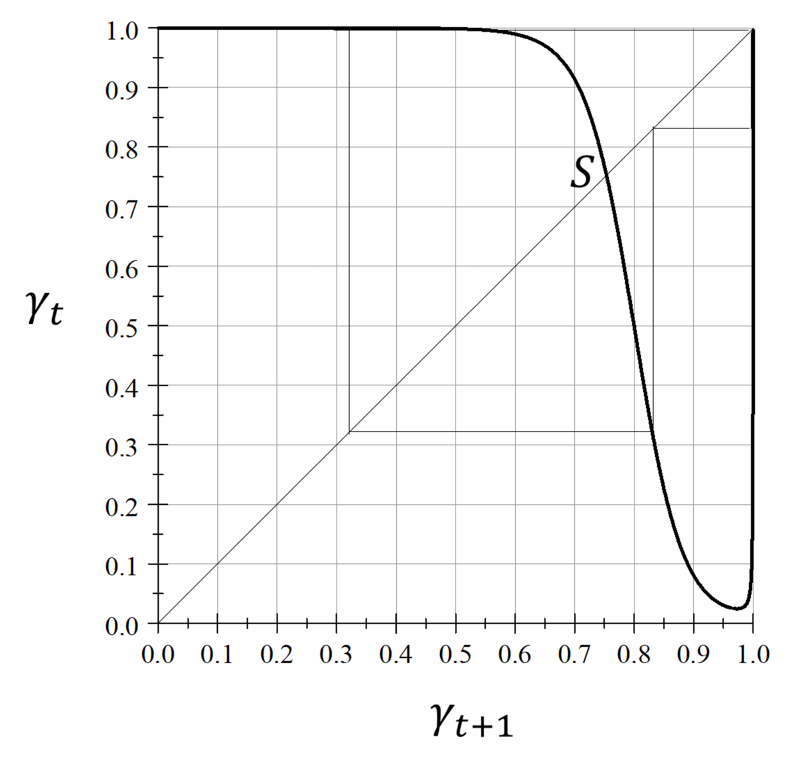
Figure 1. γ t = h ( γ t + 1 )